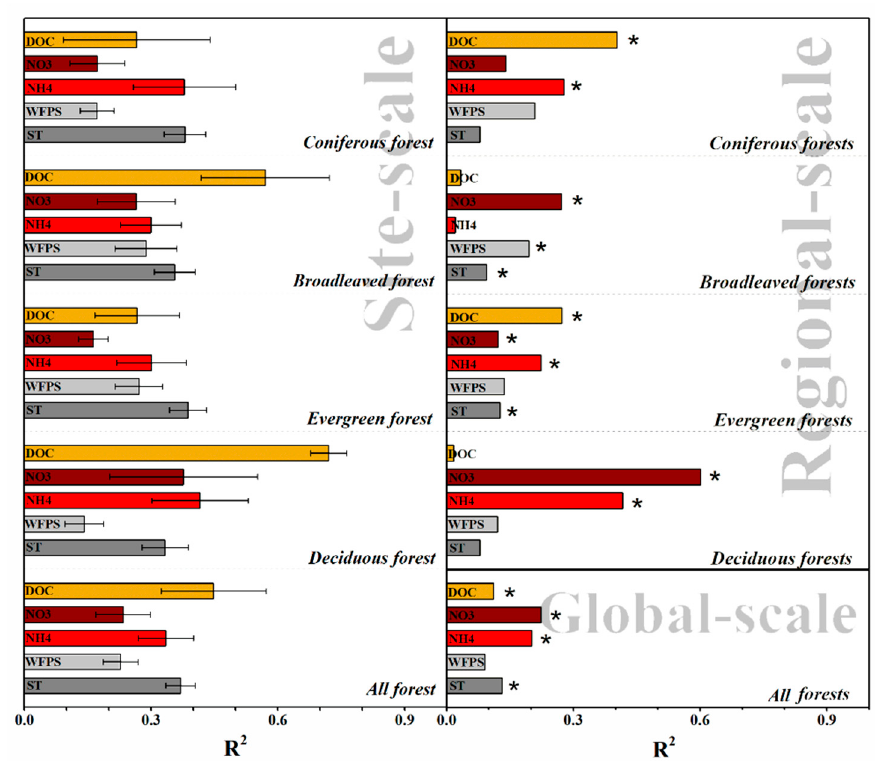
Figure 4. Comparison of coefficients of determination ( R 2 ) of relationships between the edaphic factors (DOC—DOC concentration, %; NO3—NO 3 − concentration, mg kg − 1 ; NH4—NH 4+ concentration, mg kg − 1 ; WFPS—water filled pore space, %; and ST—soil temperature, °C) and N 2 O fluxes from coniferous, broadleaved, evergreen, deciduous, and global forest groups on different scales. * Represents significant relationship ( p < 0.05).